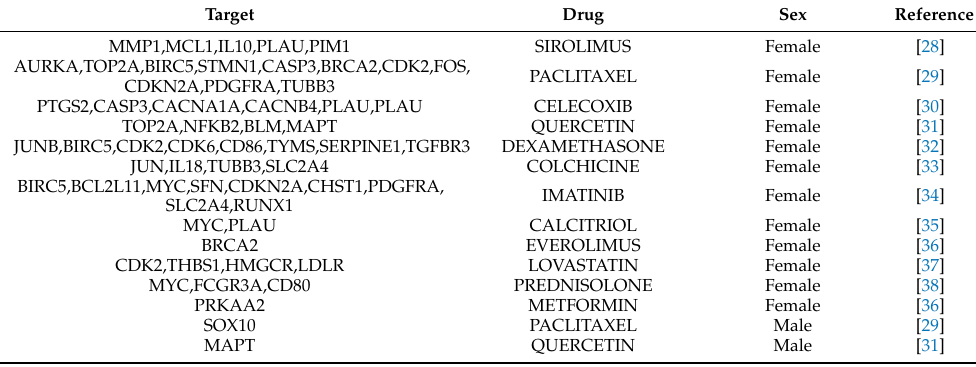
Table 1. Summary of pre-clinical and clinical trials using potential drugs treating AVF